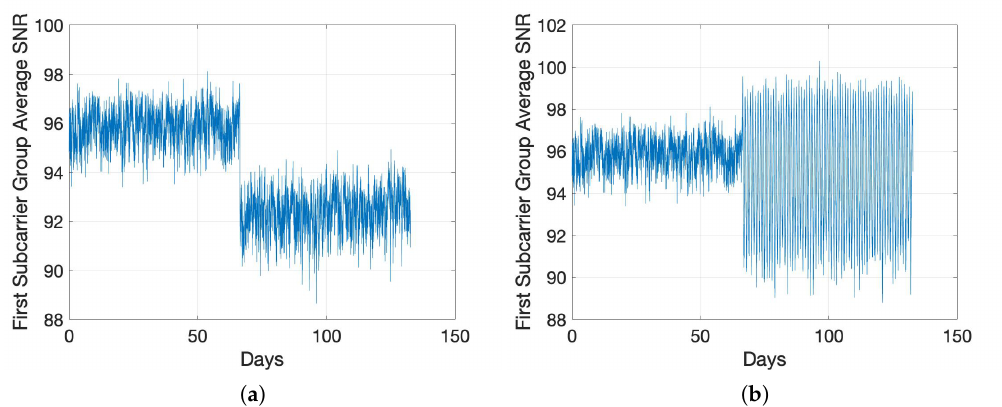
Figure 4. Average SNR for the batch i = 1. ( a ) Concentrated Fault; ( b ) Termination Impedance